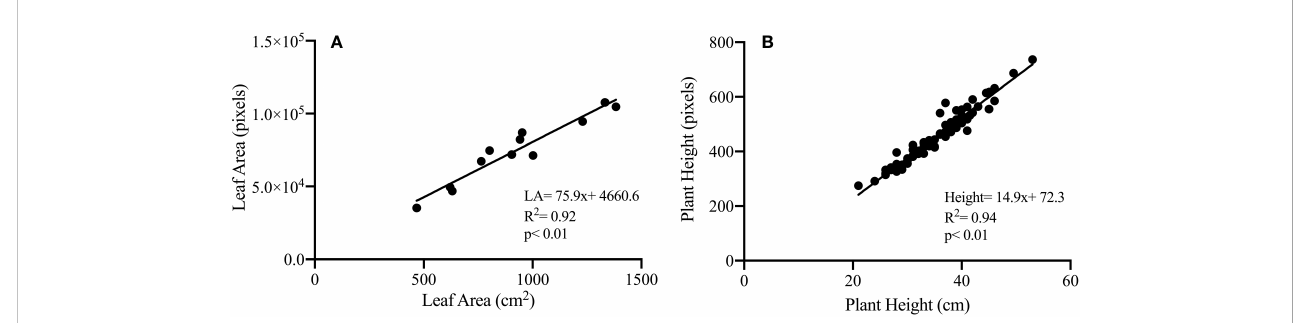
FIGURE 4 Illustration of correlation between phenotypic traits measured destructively and based on visible light image analysis: projected leaf area ( cm 2 ) measured destructively and plant biomass (total plant pixels) derived from image analysis ( cm 2 ) (A) ; plant height ( cm ) measured destructively and plant height (pixels) derived from image analysis (B) for control and dry-down